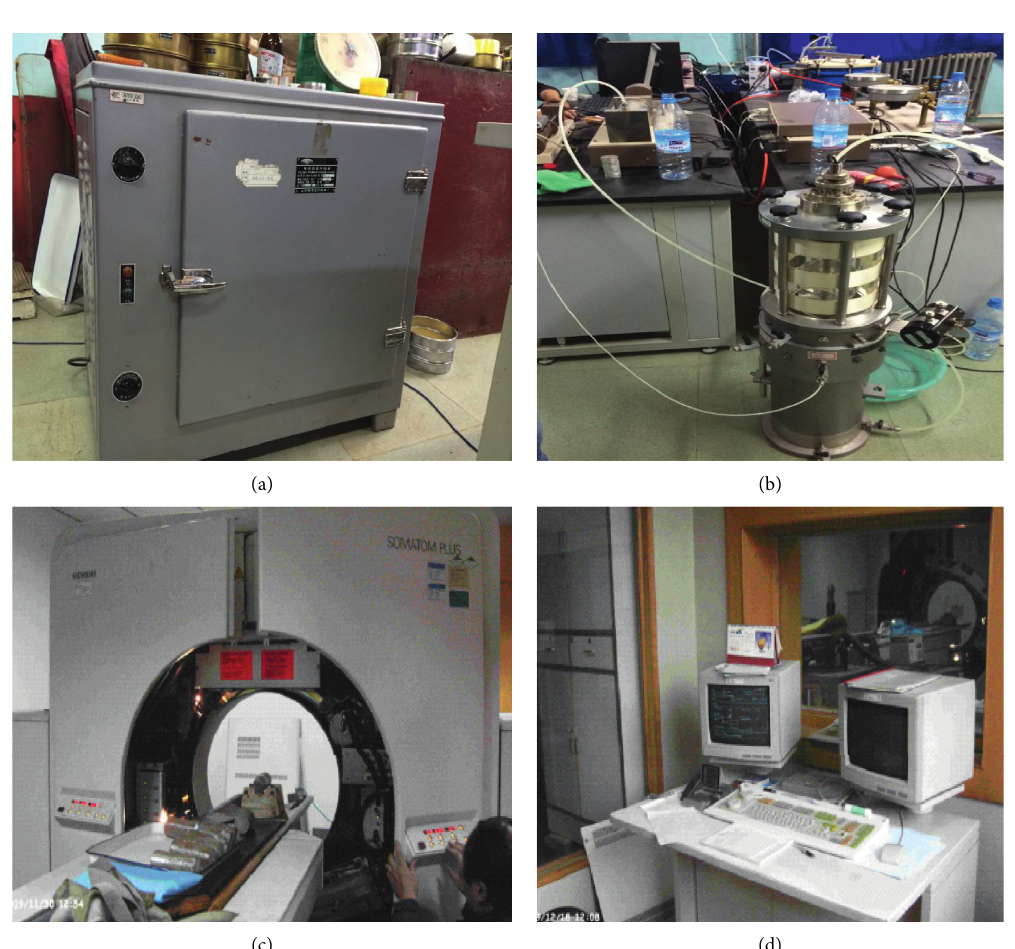
Figure 1: Test equipment. (a) Electric heating constant temperature drying box. (b) GDS three-axis instrument. (c) SIEMENS SOMATOM Plus X-ray spiral CT frame. (d) Computer supporting the CT machine.